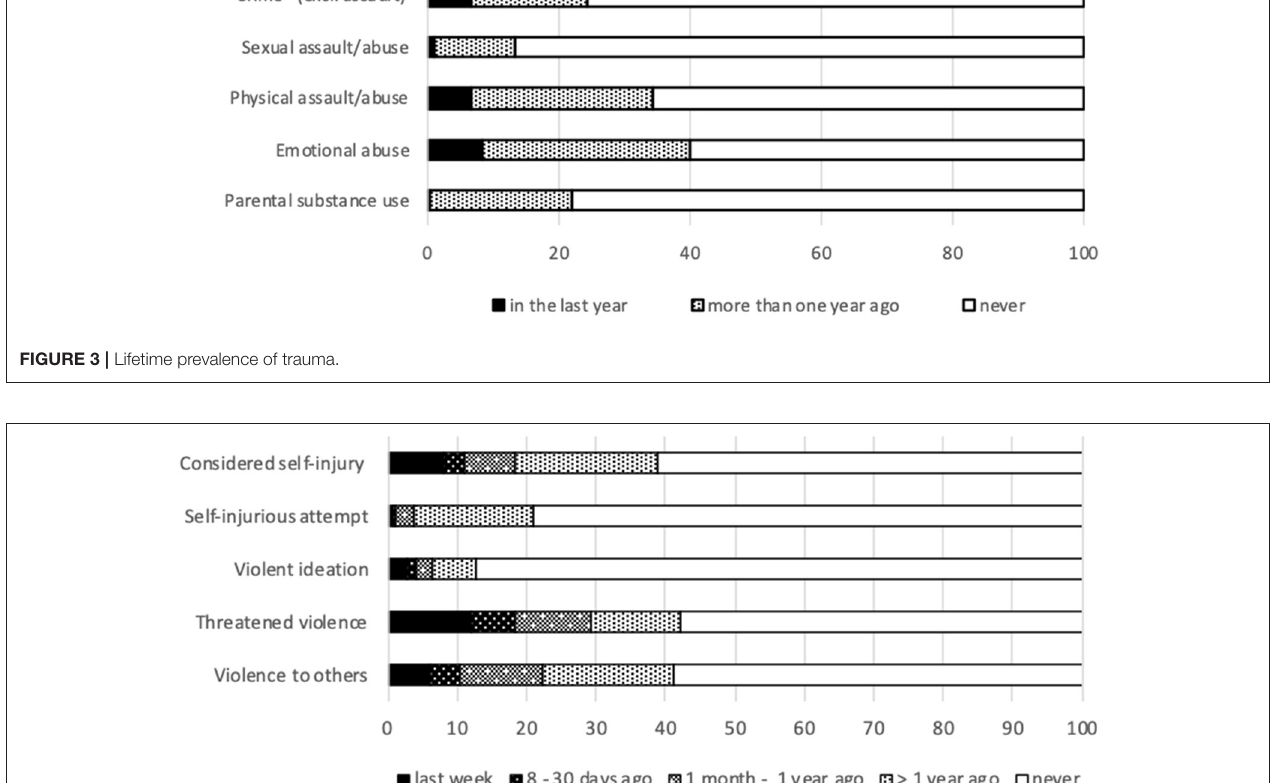
supports that in high-income countries, with elaborated care systems, homelessness mainly affects people with complex needs